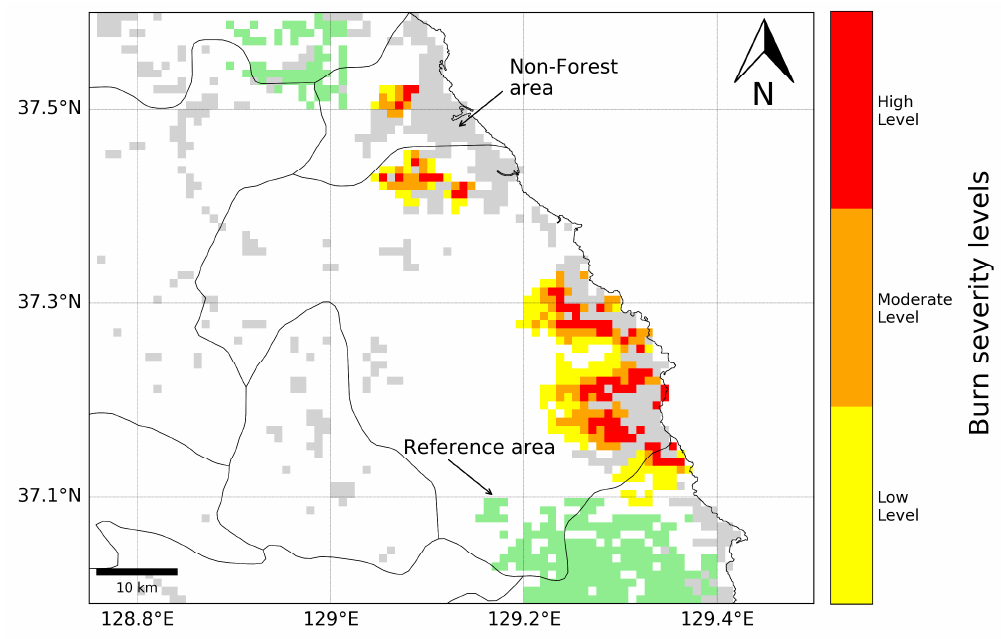
Figure 2. Forest fire areas detected using dNBR of Terra/MODIS. Yellow-Orange-Red pixels indicate forest fire severity divided into three groups using MODIS-based dNBR. Green pixels indicate reference area. Non-forest areas, indicated by grey pixels, were eliminated.